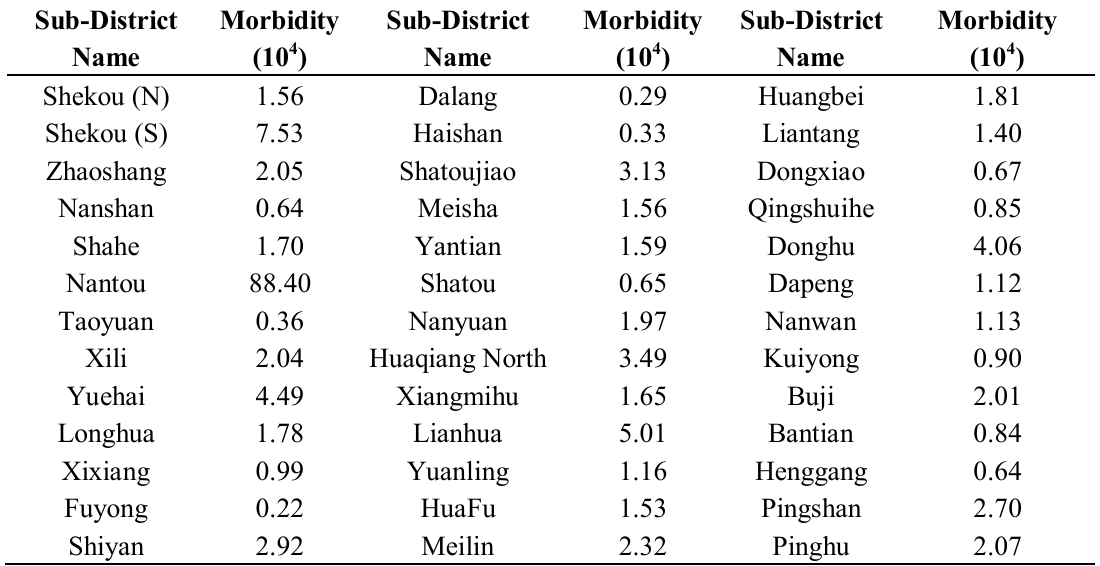
Table 3. The hepatitis B morbidity in each